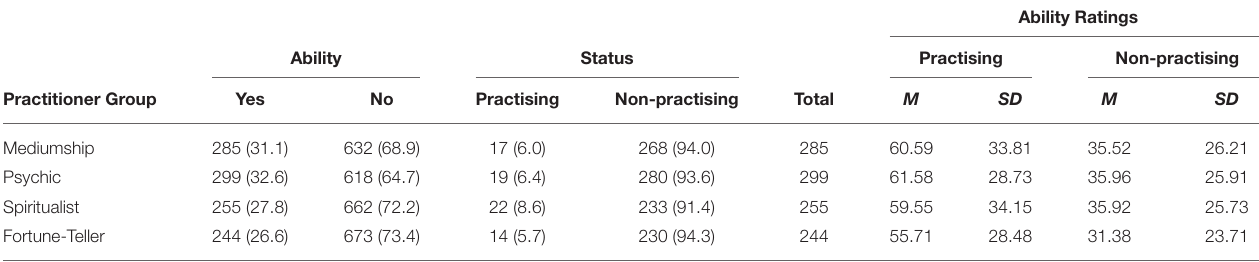
TABLE 1 | Frequencies (and percentages in brackets) of professed ability and practitioner groups.